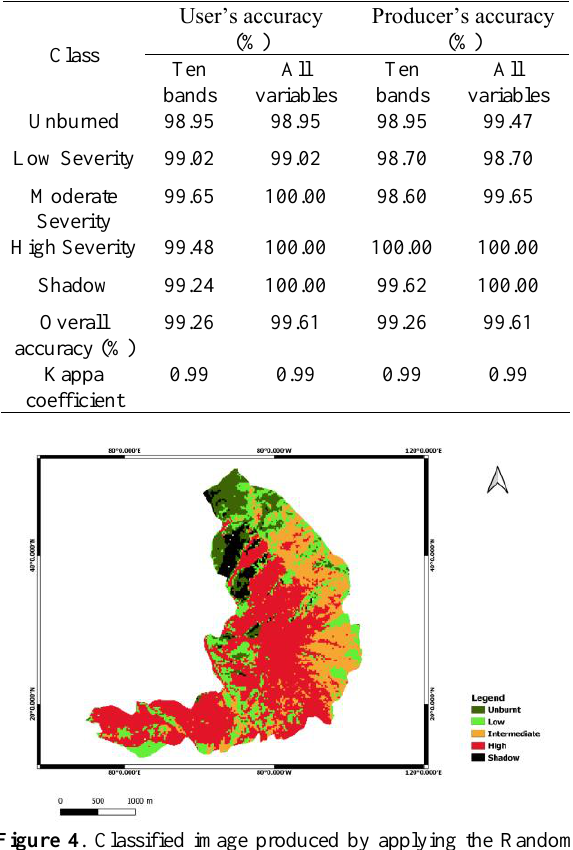
Table 3. User’s and Producer’s classification accuracies as a function of the input features